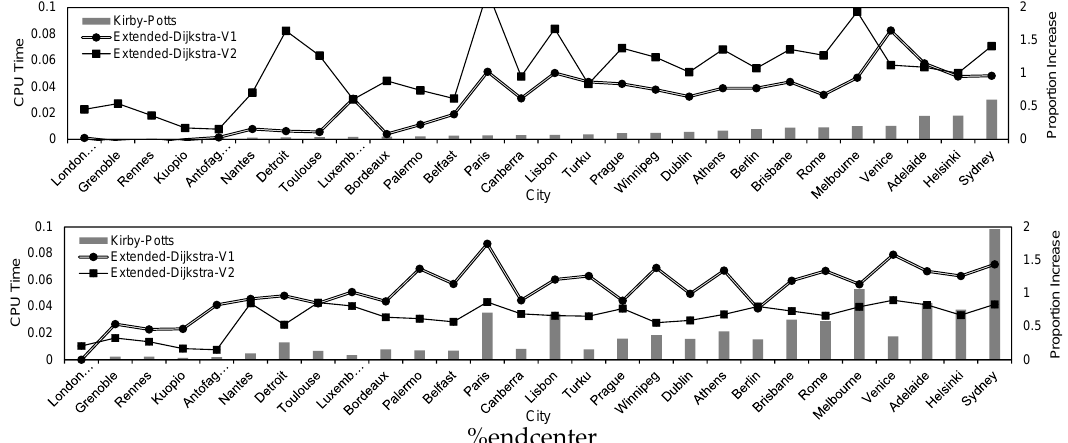
Figure 10. Comparison of run times for the real-world problem instances allowing no walks ( top ), and walks of up to 1 km ( bottom